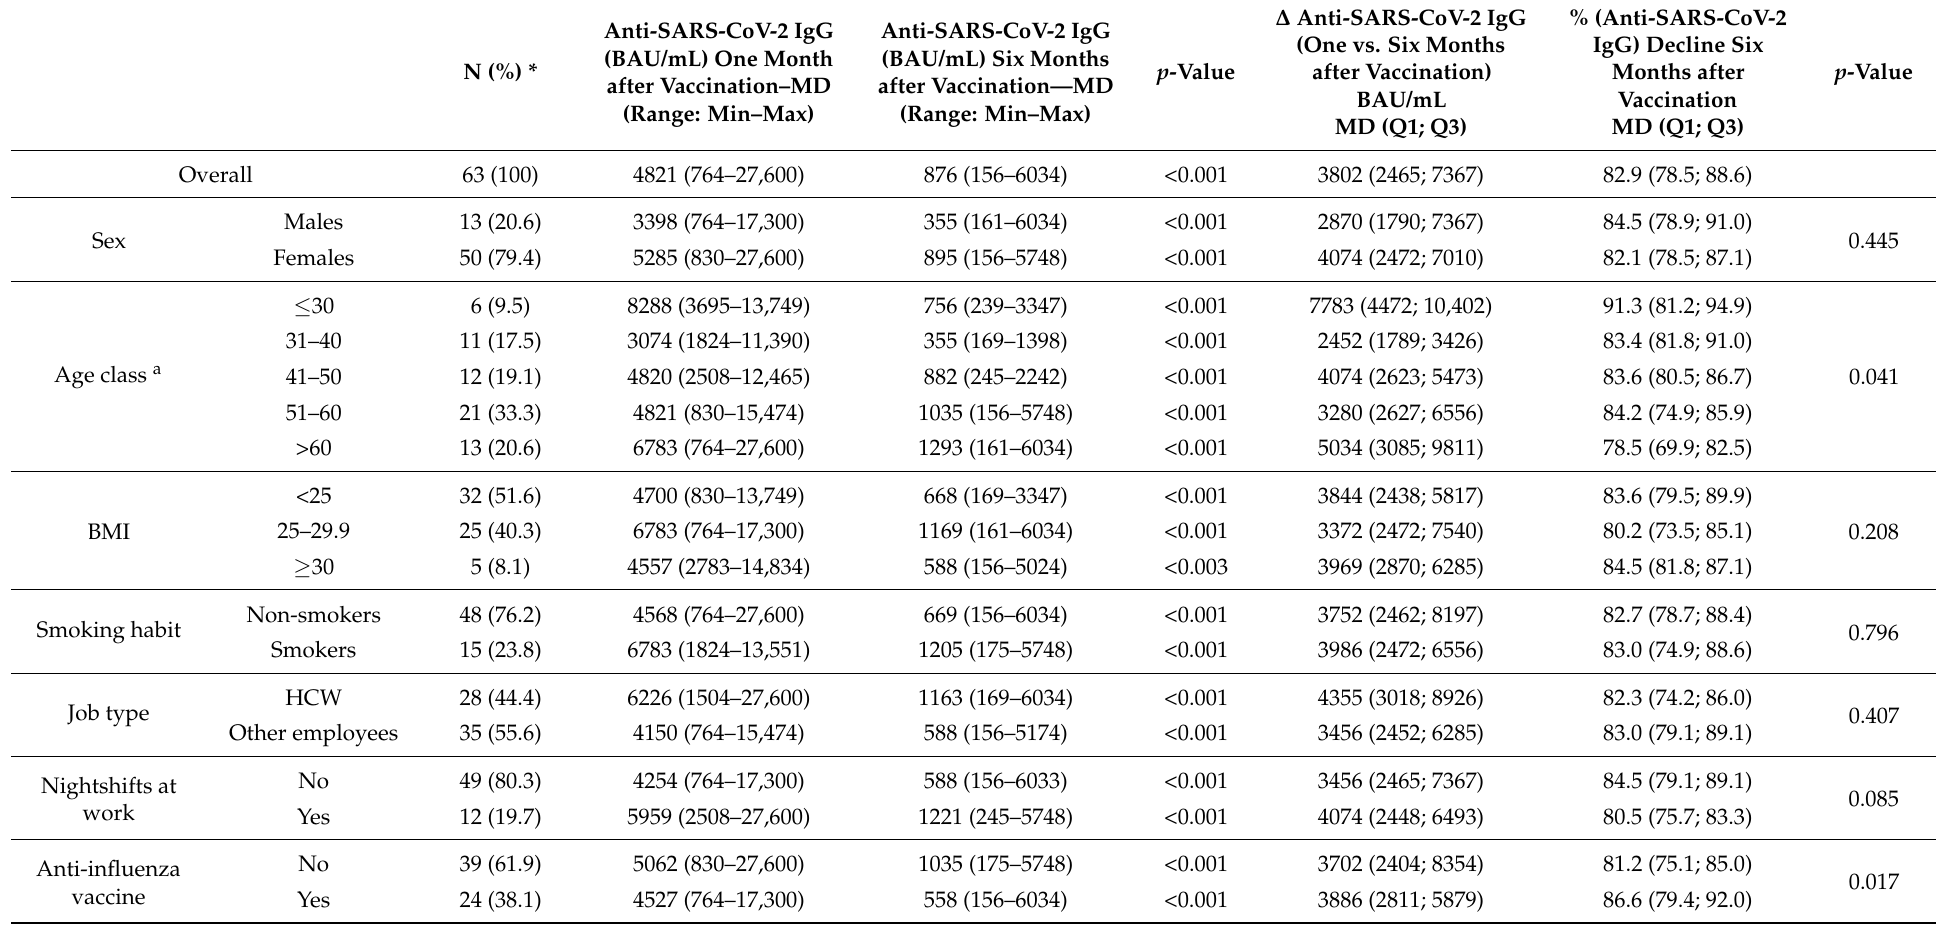
Table 1. Titer (BAU/mL, median and range values) and titer decay ( ∆ , %) of neutralizing anti-SARS-CoV-2 antibodies, measured 1 vs. 6 months after the second dose of the BNT162b2 vaccine in 63 workers of an Italian nursing home, grouped according to the main individual and occupational